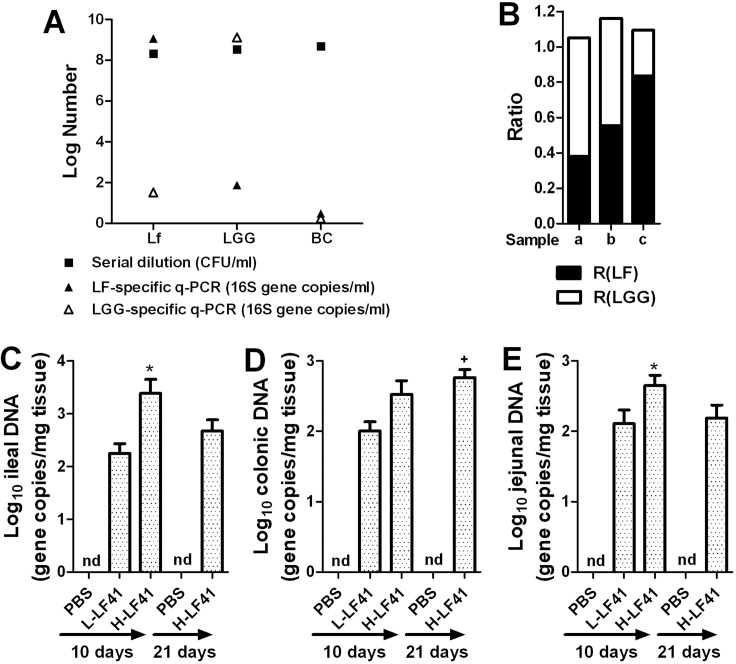
Validation of q-PCR for quantitation of LF and effect of LF41 administration on LF-specific 16S rRNA levels in intestinal tissues.
(A) LF41, BC41, or LGG was cultured in MRS broth at 37°C overnight. An aliquot of culture from each culture was dilution-plated on MRS agar (to enumerate each strain). Total bacterial genomic DNA was isolated from an aliquot of each culture and analyzed by q-PCR using the primers specific to the 16S rRNA of either LF or LGG. Black and white triangles denote log numbers of 16S rRNA gene copies determined by LF- and LGG-specific q-PCR, respectively; black squares denote log numbers of bacteria determined by serial dilution. (B) MRS broth was co-inoculated with LGG and low, middle, or high dose of LF41, grown at 37°C overnight. Total bacterial genomic DNA was isolated from an aliquot of each sample and analyzed by q-PCR using the primers specific to 16S rRNA of Lactobacillus, LF, or LGG. The samples of a, b, and c denote the co-cultures of LGG with low, middle, and high dose of LF41, respectively; “R(LF)” and “R(LGG)” denote the ratios of the respective 16S rRNA gene copies determined by LF- and LGG-specific q-PCR to the gene copies by Lactobacillus-specific q-PCR. (B)(C)(D) Mice (n = 8) were orally inoculated either for 10 days with PBS, L-LF41, or H-LF41, or for 3 weeks with PBS or H-LF41, and LF-specific 16S rRNA gene levels in terminal ileum (B), proximal colon (C), and distal jejuna (D) determined by q-PCR. Results are expressed as log10 of the 16S rRNA gene copies per mg of tissue samples. Values of are shown as mean ± SEM. * P < 0.05 compared to L-LF41 or H-LF41 (21 days); + P < 0.05 compared to H-LF41 (10 days); nd, not detected. Results are representative of 2 experiments with similar results.